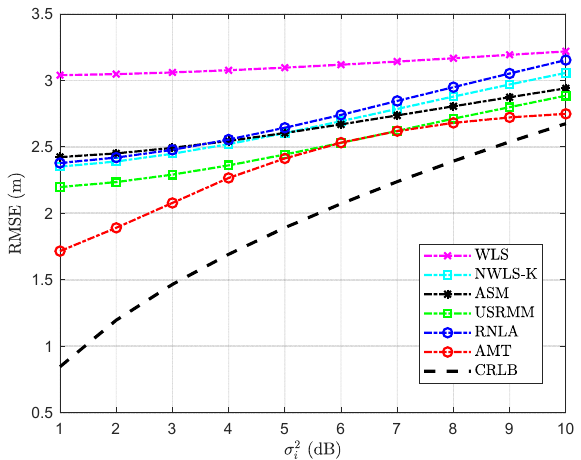
σ 2 with P 0 = − 55 dBm, N = 10, α f = 0.06 dB/m, and the side length i